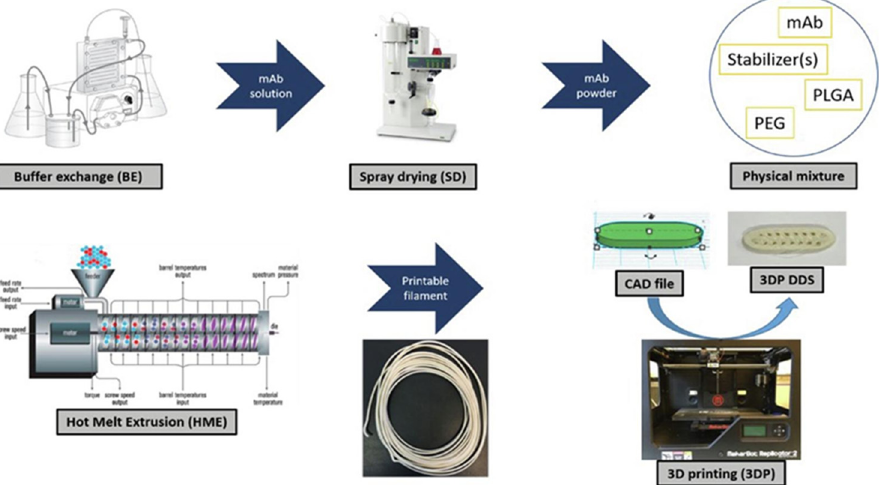
Figure 7. Preparation of PLGA-based Composite load mAb using FDM technology, Reprinted with permission from ref. [62]. Copyright 2021 IOP